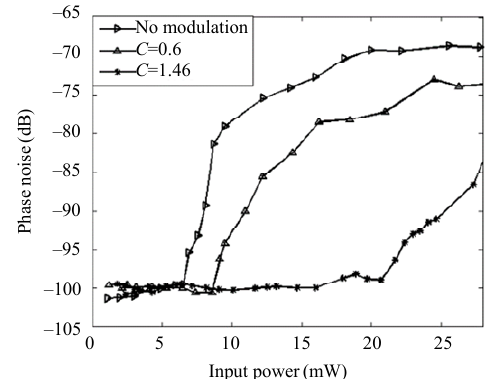
Fig. 14 Phase noise versus input power with different modulation indexes in